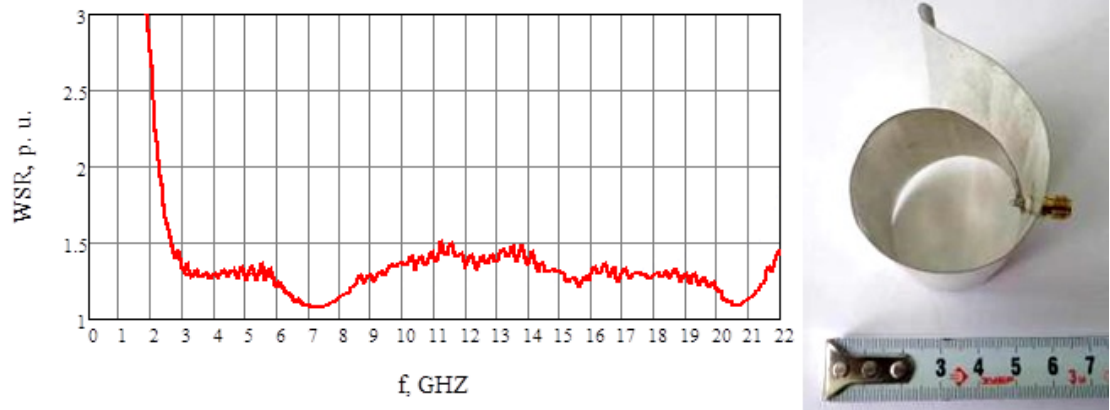
Figure 6. Combined ultra-wideband (UWB) antenna of the “Snail” type.